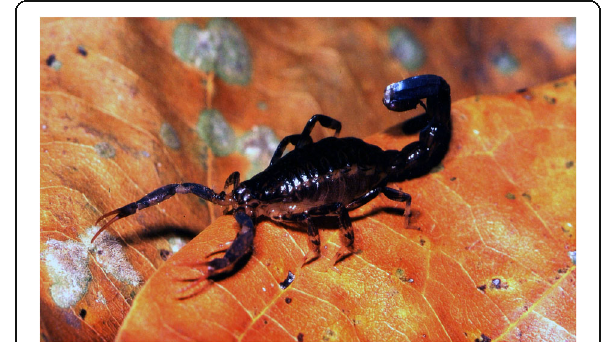
Fig. 10 Ananteris charlescorfieldi Lourenço (Buthidae, Ananterinae). Adult female from